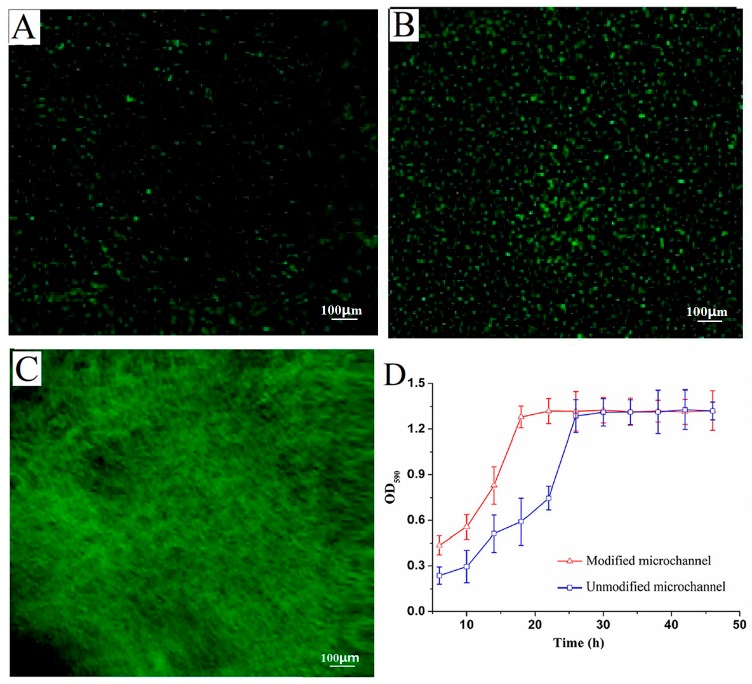
Figure 3. The photos of recombinant E. coli BL21-pET28a- egfp on unmodified ( A ) and modified ( B ) microchannel surfaces under inverted fluorescence microscope. The photo of recombinant E. coli biofilms on the modified microchannel surfaces under inverted fluorescence microscope after 30 h ( C ). The total biomass of recombinant E. coli biofilms were compared in unmodified and modified microchannels ( D ).